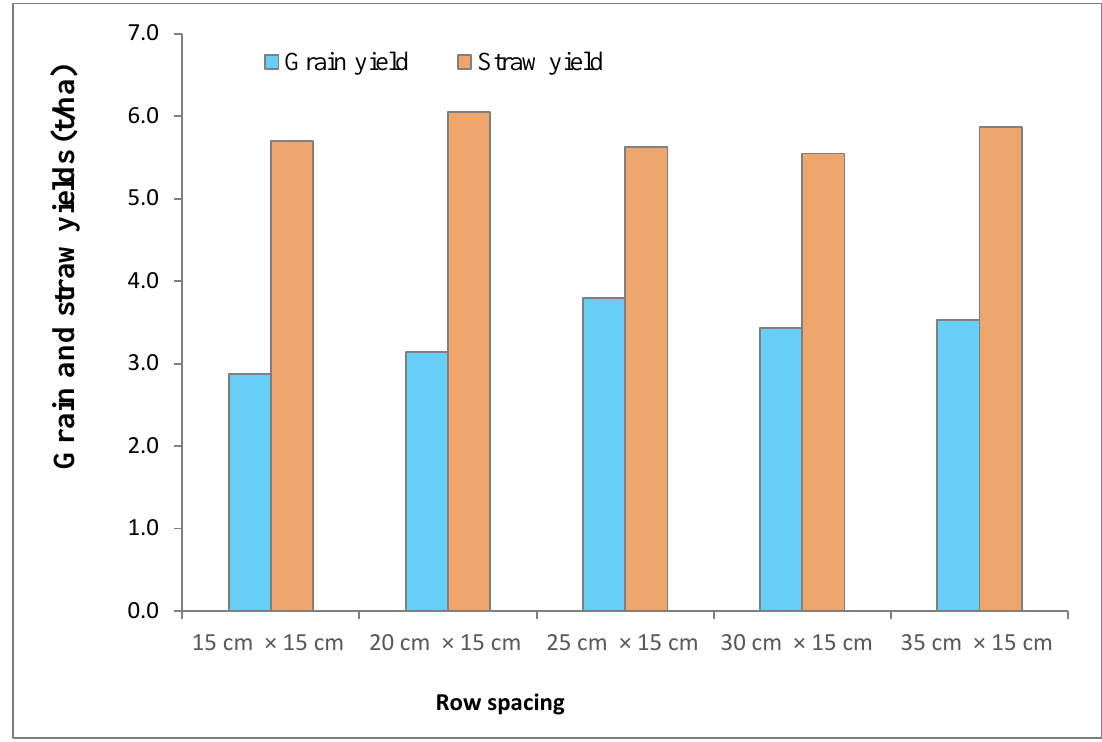
Figure 2: Relation between row spacing with grain yield and straw